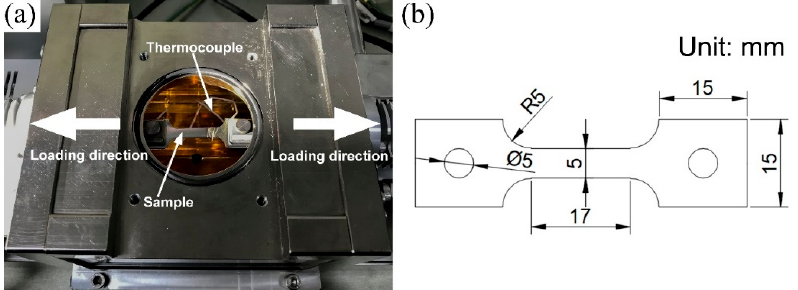
Figure 2. ( a ) The in situ tensile testing stage of VL2000DX-SVF15FTC high temperature confocal scanning violet laser microscope and ( b ) the dimensions of the specimen.